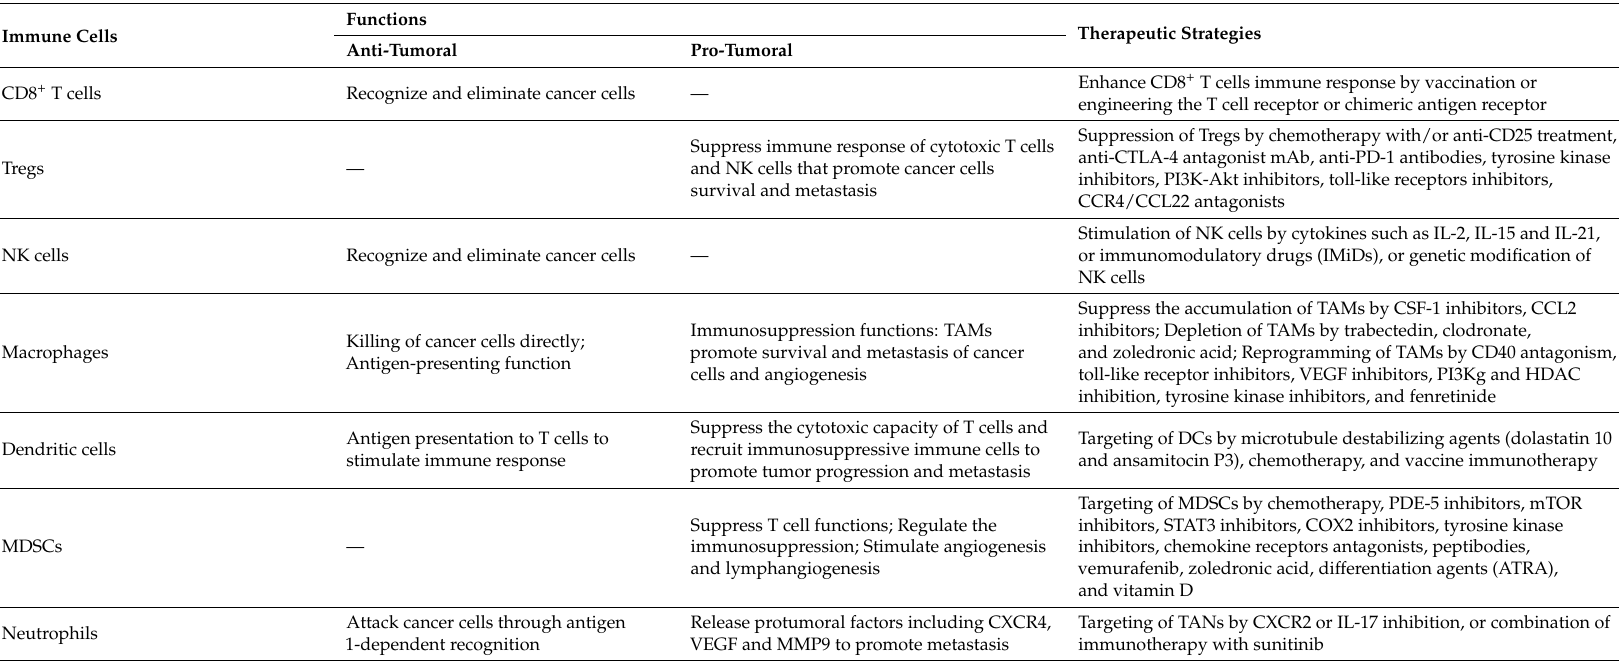
Table 1. The role of immune cells in cancer progression and metastasis, and their therapeutic